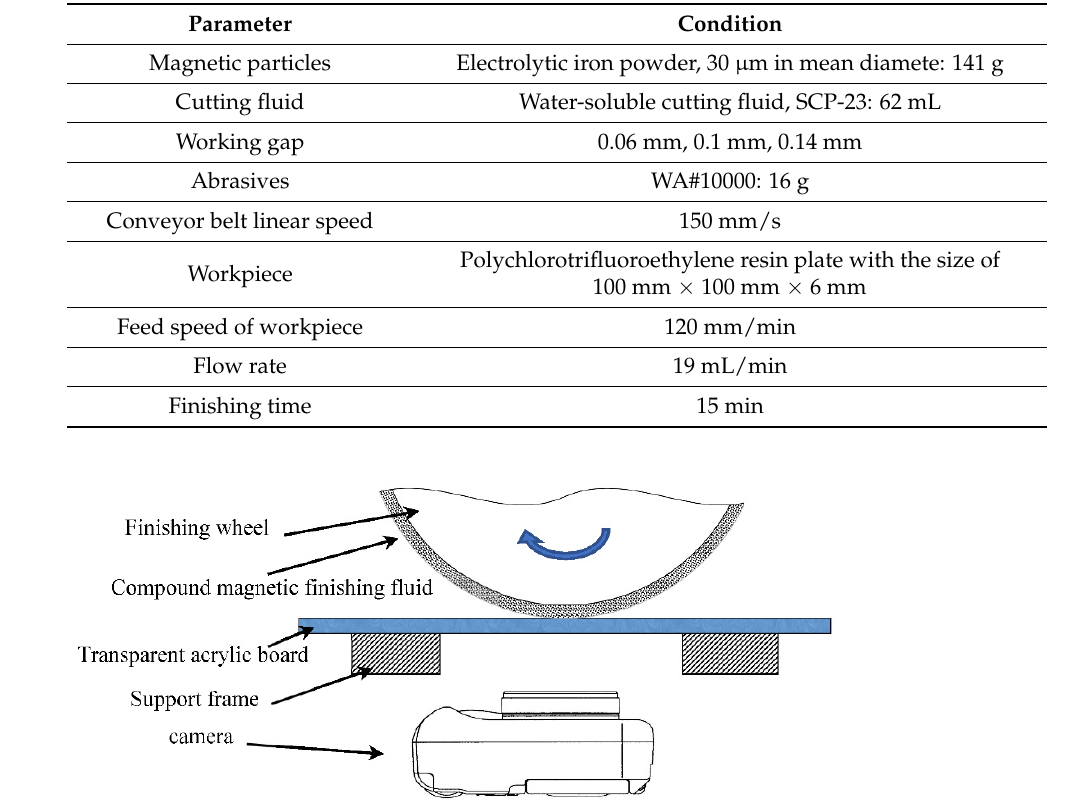
Figure 15. States of the compound magnetic finishing fluid in the finishing area with different working gaps.